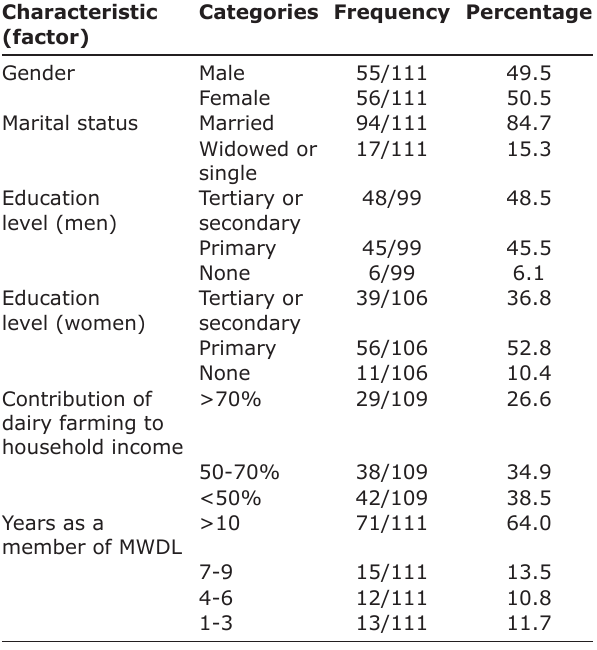
Table-1: Household demographics in 111 smallholder dairy farms in Mukurwe-ini district, Kenya, 2013. Characteristic